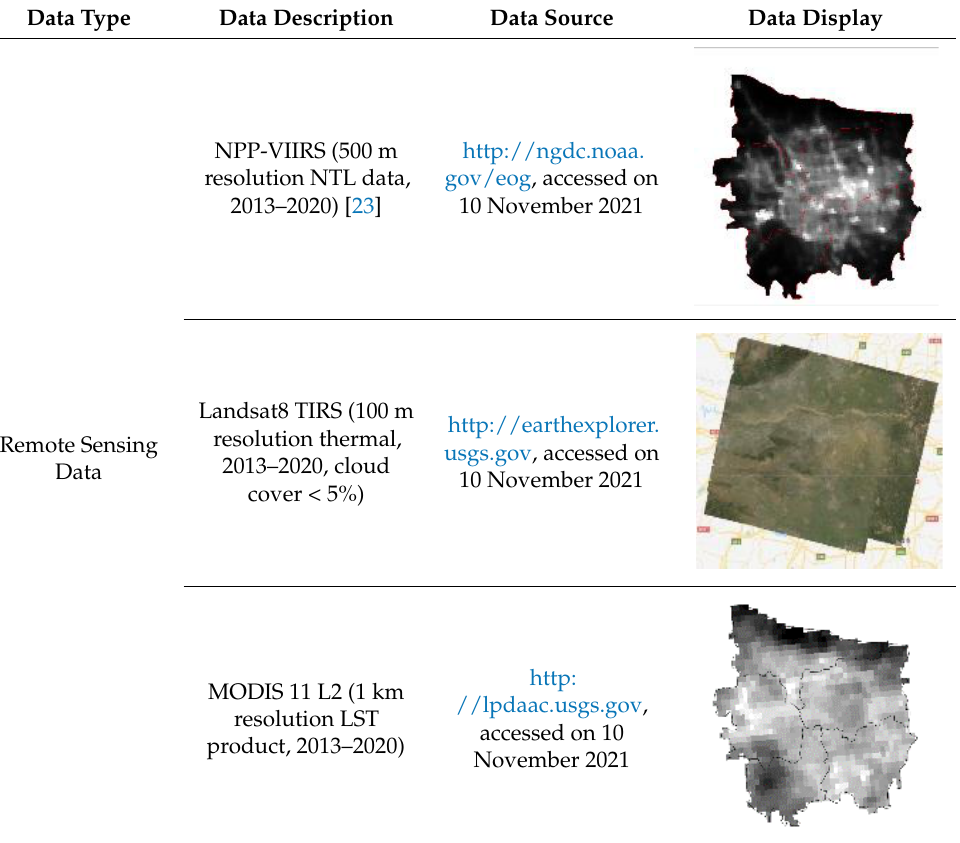
Figure 2. The month-by-month temperature box plot for 2013 – 2020. The height difference of the box plot represents the temperature dispersion for that month from 2013 – 2020, and the red line is the temperature fit for each season. (Data source: https://data.cma.cn/, accessed on 10 November 2021). Table 1. Data sources.